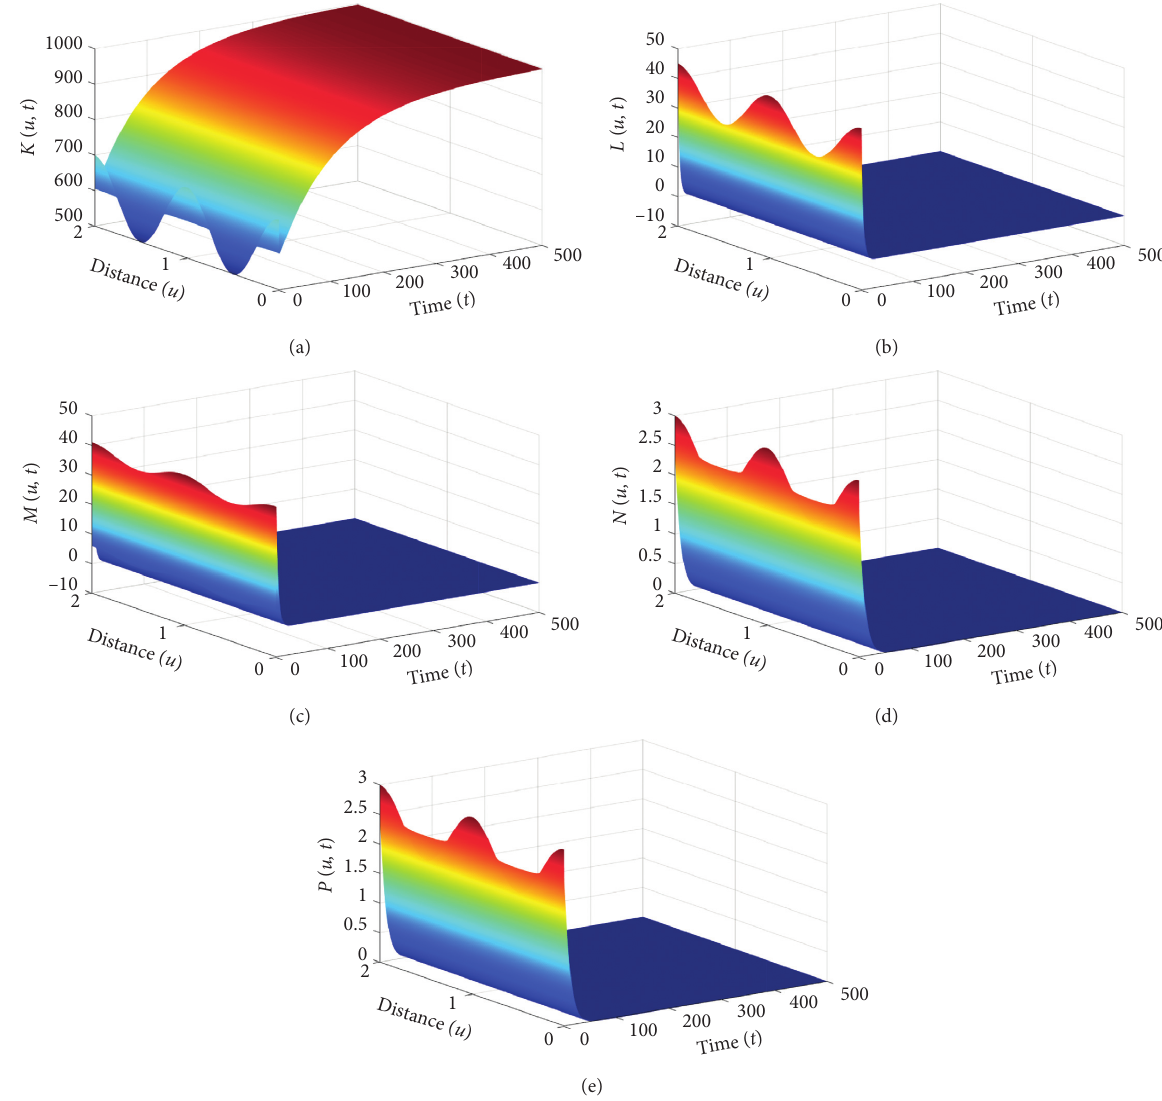
Figure 1: Taking Strategy 1 ( R � ( 1000 , 0 , 0 , 0 , 0 ) is asymptotically stable. (a) Target cells. (b) DENV-infected cells. ≤ 1), the equilibrium Ω 0 0 (c) DENV particles. (d) Heterologous antibodies. (e) Homologous